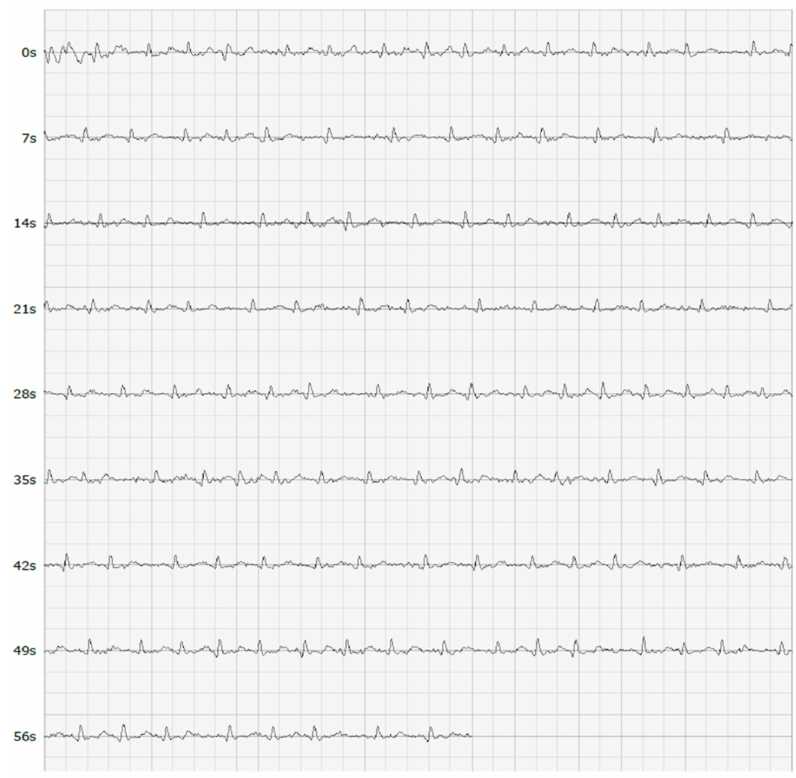
Figure 2. A single lead ECG tracing showing